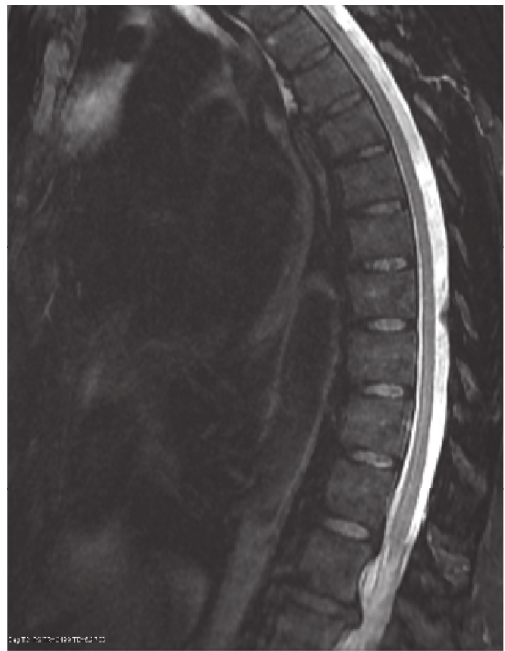
Figure 3: MRI with contrast, demonstrating facet spondylosis and ligamentum flavum thickening at T9-10 with mild central spinal stenosis but no cord compression. Disc degeneration at the thoracolumbar junction.